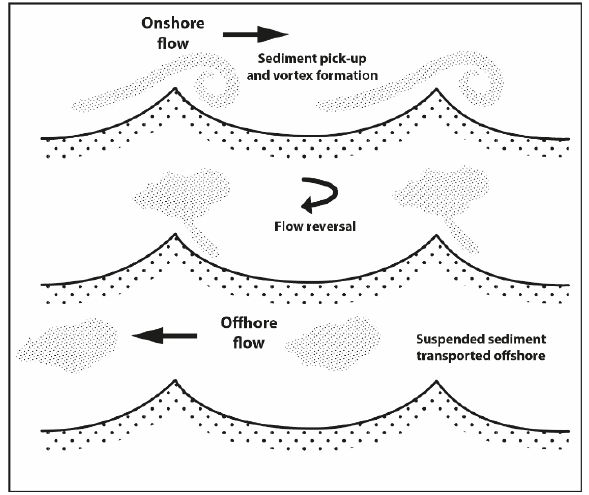
Figure 2. Idealized sketch of sediment clouds produced by turbulent vortex generation over steep wave ripples in an oscillatory flow. Reprinted from Masselink and Hughes [53] with permission from Informa UK Ltd through PLSclear.